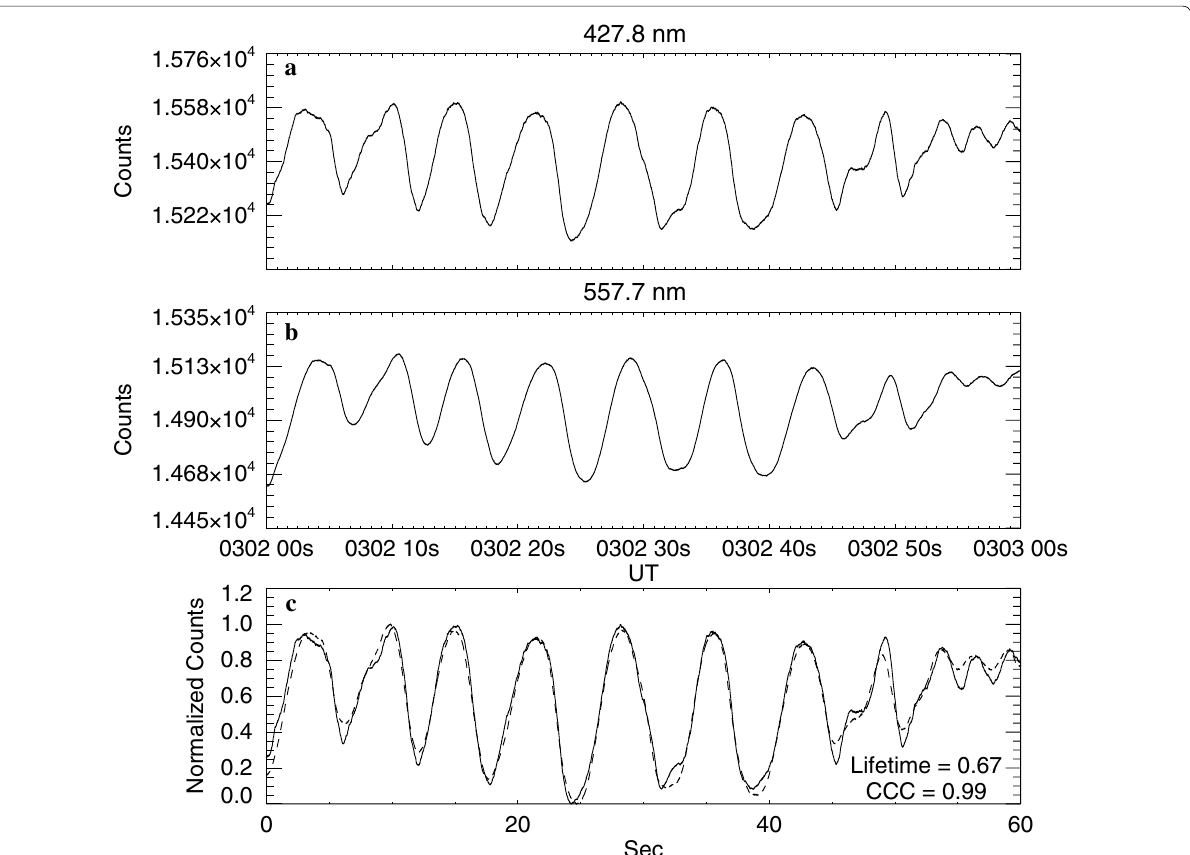
Fig. 2 Time‑series of auroral emissions at a 427.8 nm and b 557.7 nm observed at Tromsø for a 1‑min interval from 03:02 UT to 03:03 UT on 24 February 2018. c Comparison of the two time‑series of the 557.7 nm (dashed line) and 427.8 nm (solid line) emissions. The time‑series of the 427.8 nm is delayed by 0.67 s, which corresponds to the lifetime of O( 1